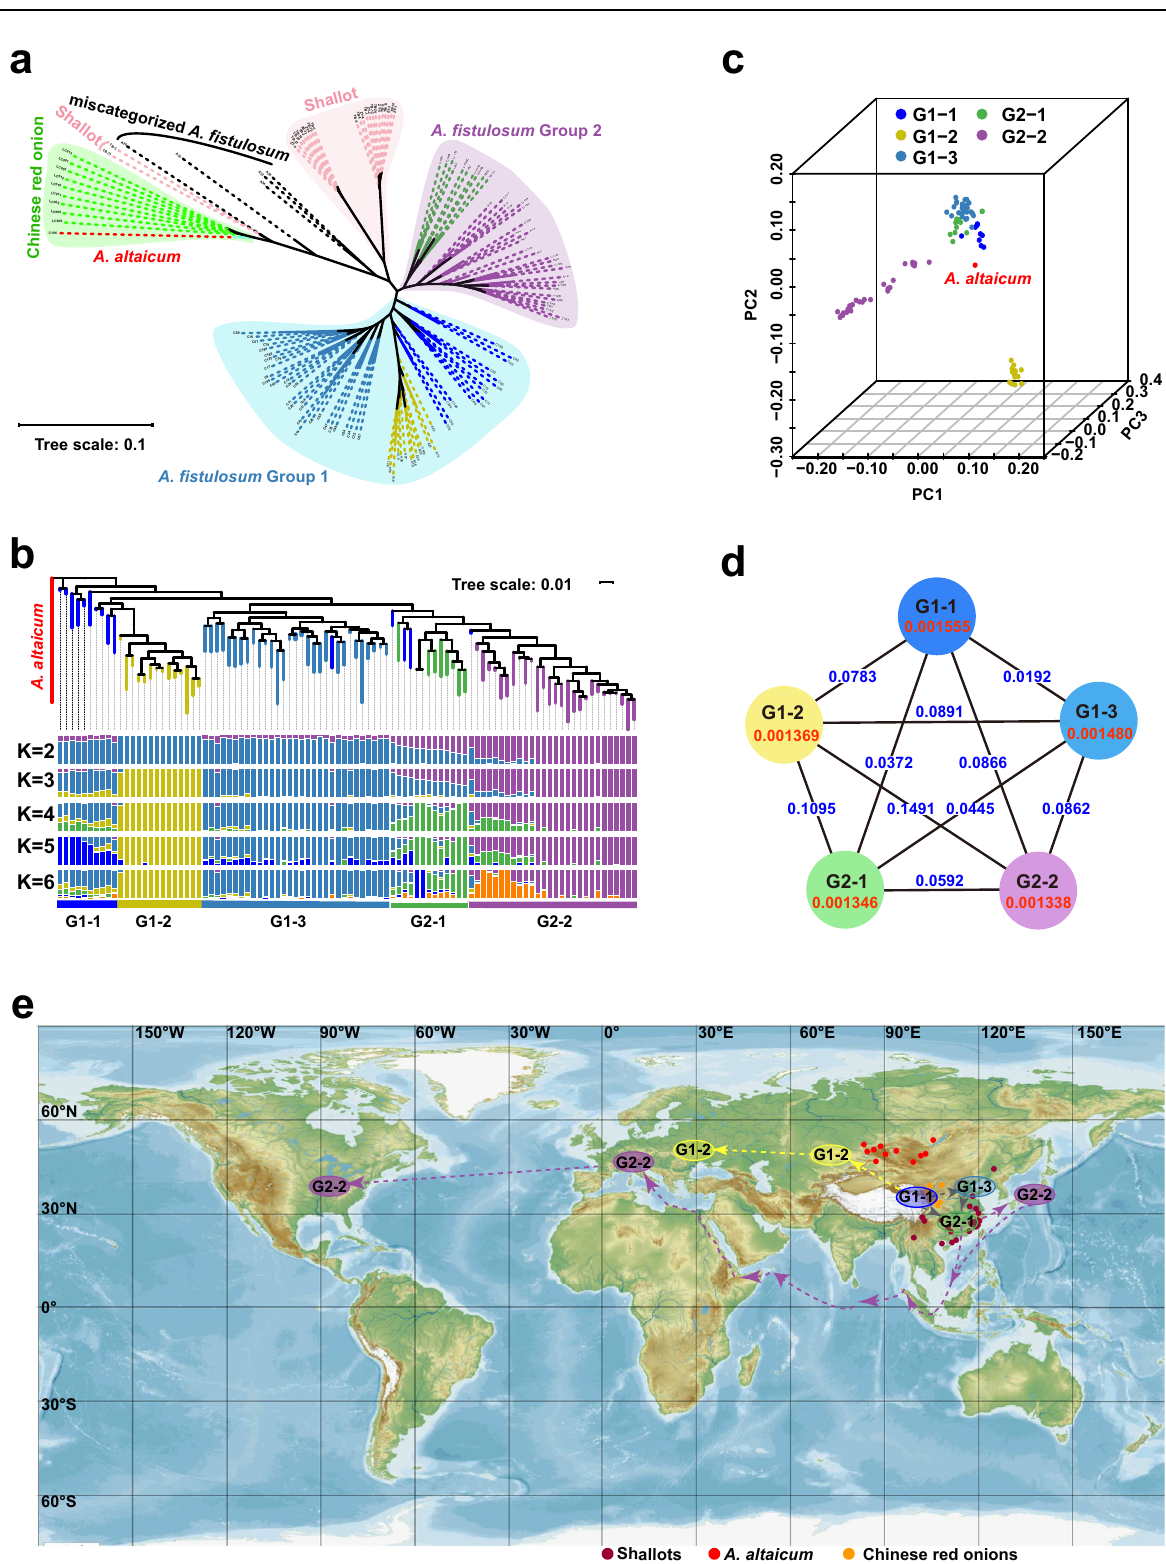
Fig. 6 | Population structure and the plausible migration routes of A. fi stulo- sum . a The maximum-likelihoodtree of 135 re-sequenced Allium accessions. b The maximum-likelihood tree and population structure of 96 re-sequenced A. fi stulo- sum accessions c , The principal component analysis of 96 re-sequenced A. fi stulo- sums accessions. d Nucleotidediversity ( π ) and population divergence( F ST ) across